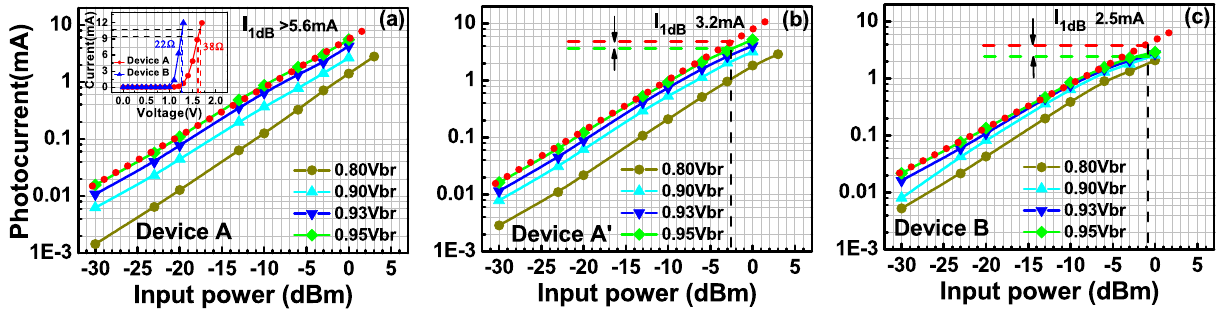
Figure 8. Measured DC output photocurrent versus input optical input power for. ( a ) Device A. ( b ) Device A ′ .